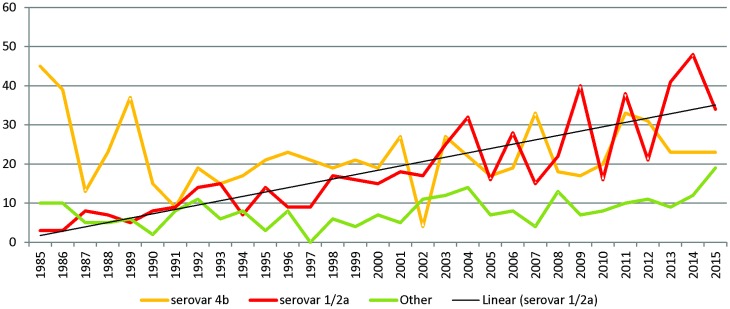
Annual incidence (/100000 inhabitants) of listeriosis caused by serovar 4b and 1/2a, and other serotypes in Belgium between 1985 and 2014.